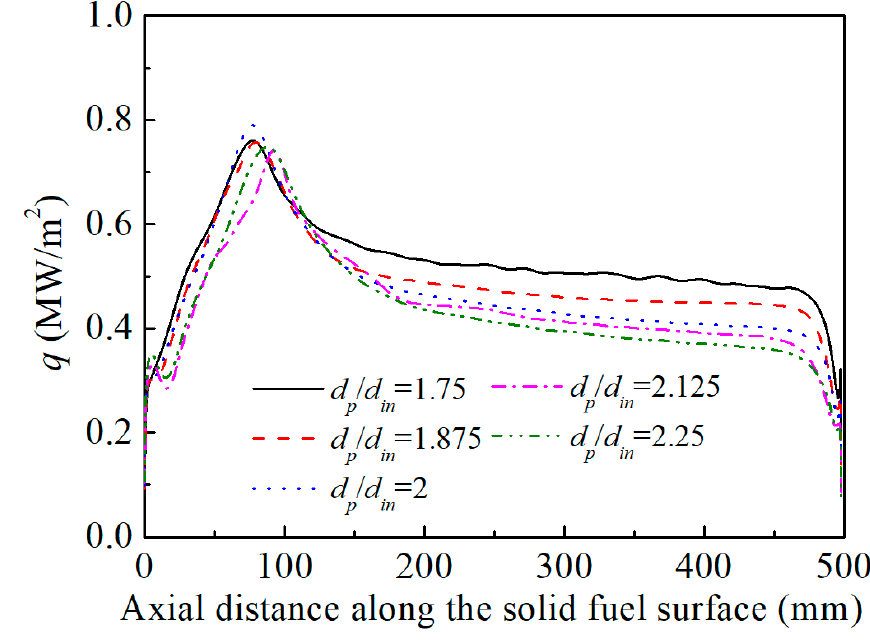
Figure 29. The local heat flux along the solid surface.